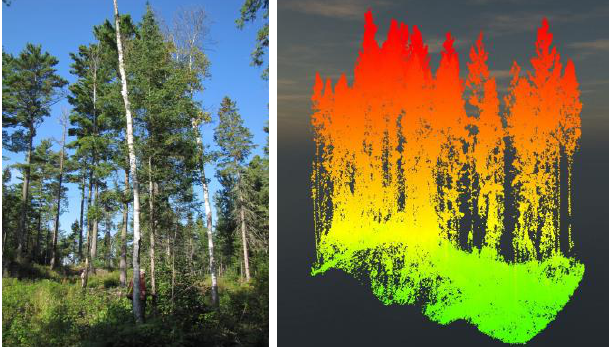
Figure 1. Ground photo of parts of the test site and 3D point